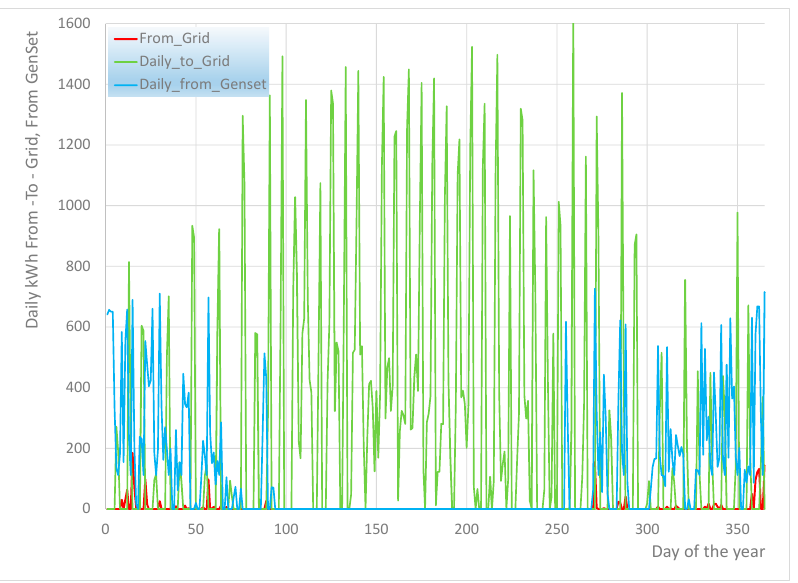
Figure 10. Daily electricity input from grid and GenSet, and daily export to the network (50 kW Genset rating).